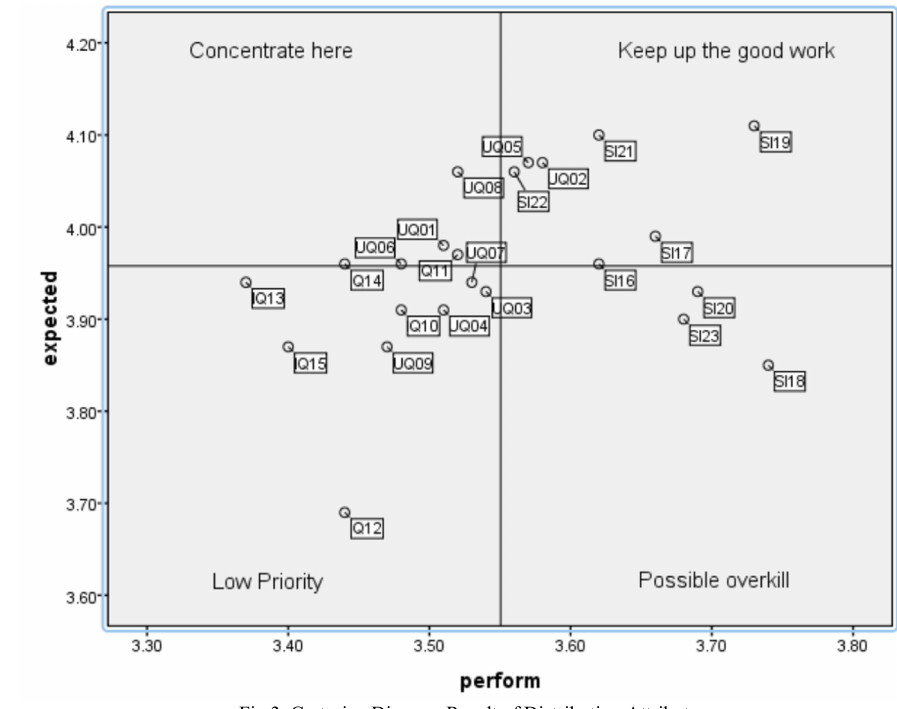
Fig.3. Cartesian Diagram Result of Distribution